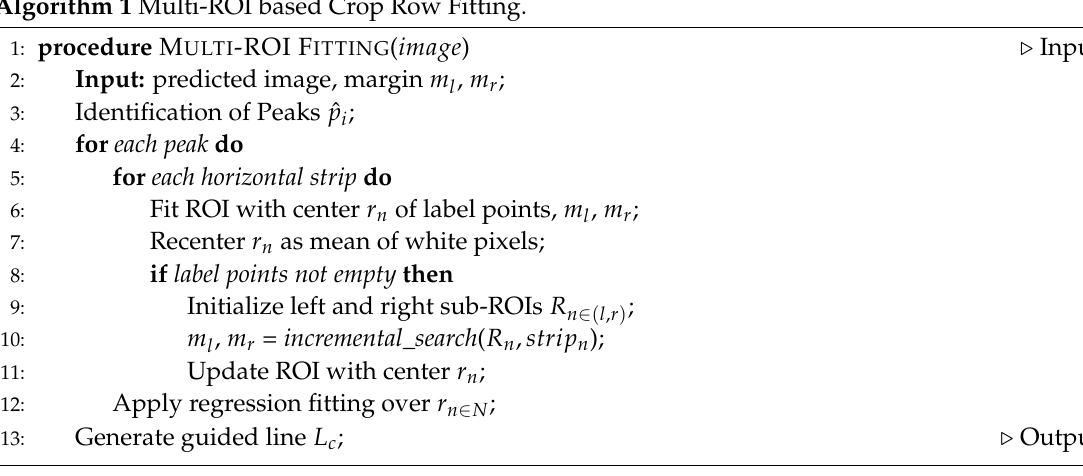
Figure 9. The figure showcases the usage of the proposed adaptive multi-ROI methodology in the cases comparing to the existing multi-ROI method. Algorithm 1 Multi-ROI based Crop Row